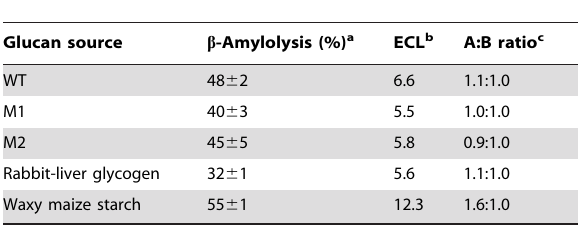
Table 4. Branch structure of glycogen and starch.